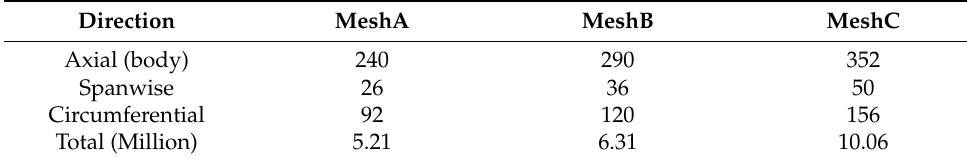
Table 2. Computational grid parameters.